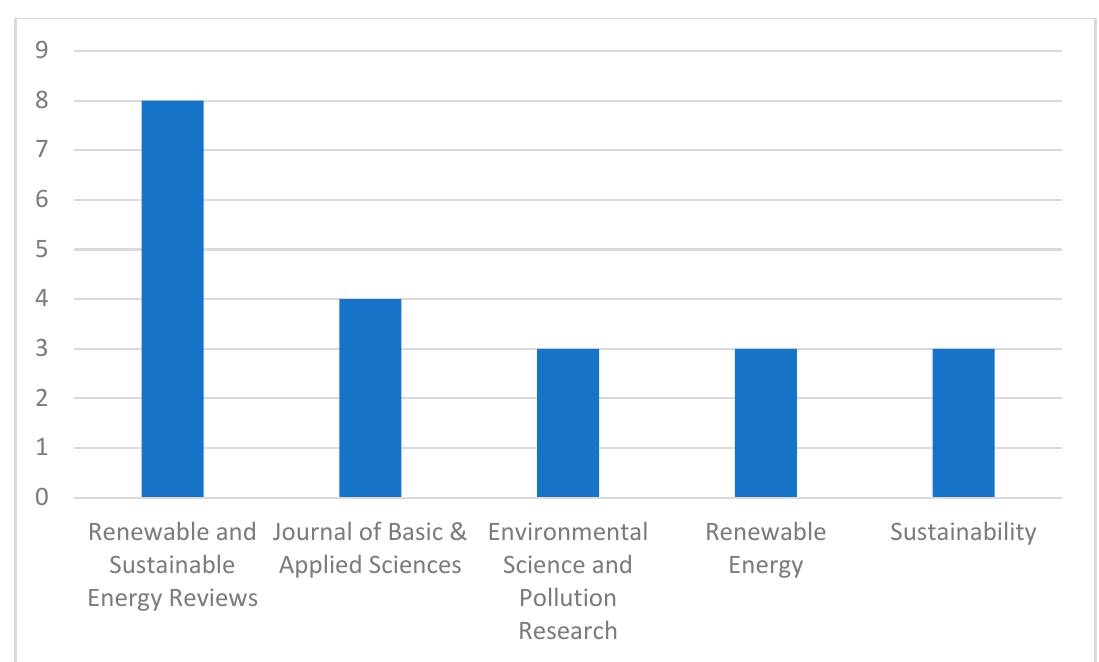
Figure 8. Top sources of the analyzed records.